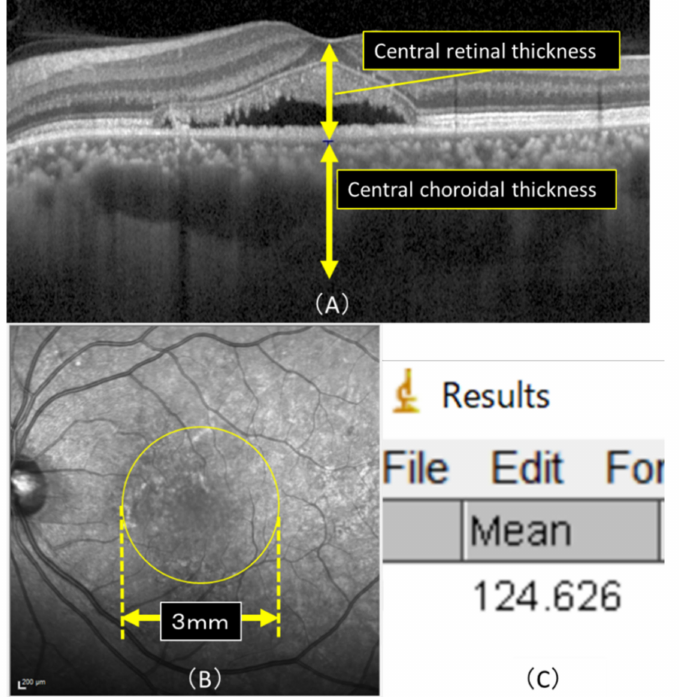
Figure 5. ( A ) Horizontal macular view on OCT. CRT was defined as the measurement from the internal limiting membrane to the subepithelial border of the RPE and CRT that from the subepithelial border of the RPE to the border of the sclera, and the measurement was conducted manually. ( B ) Mean luminance was calculated in a 3 × 3 mm area (yellow circle) of the macula using the image analysis software program ImageJ. ( C )The actual image detected by ImageJ is shown. The average luminance of the macular region in ( B ), and the lowest and highest luminance values within the macular region were detectable, with an average luminance of 124.626 in this